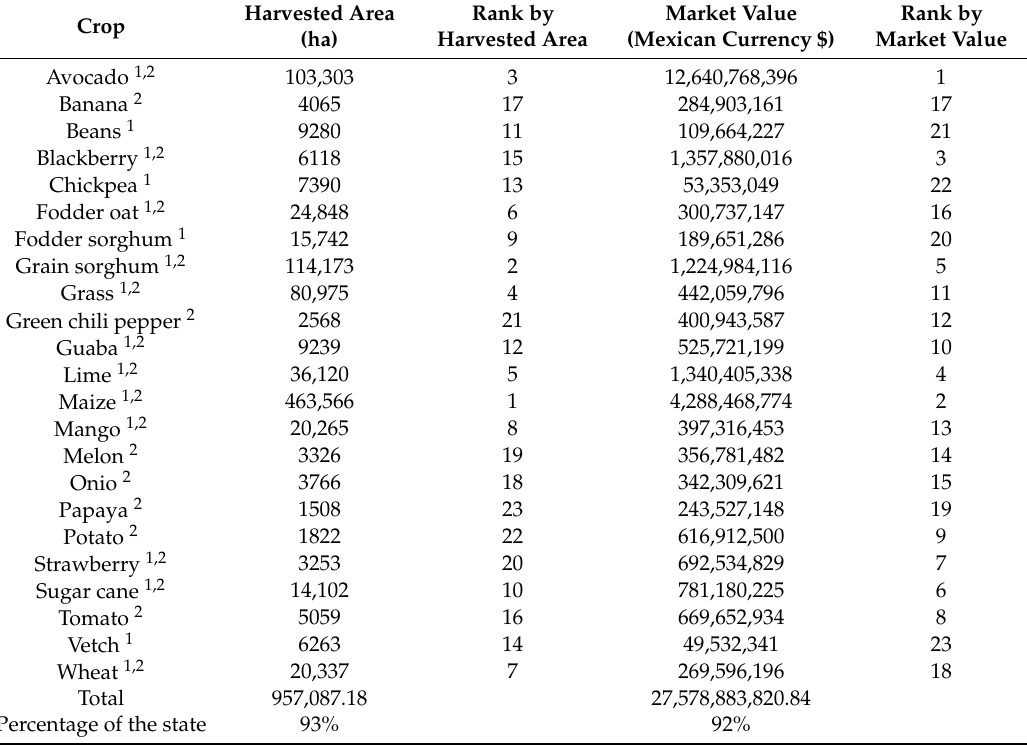
Percentage of the state